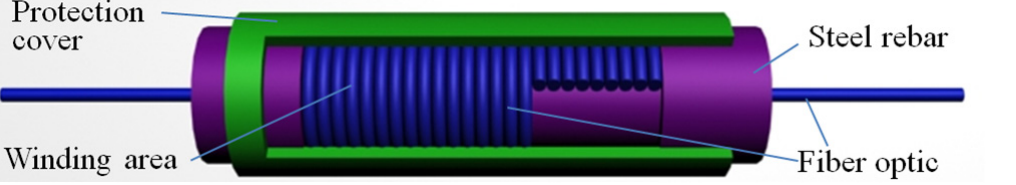
Figure 4. Basic packaging structure of the Brillouin corrosion expansion